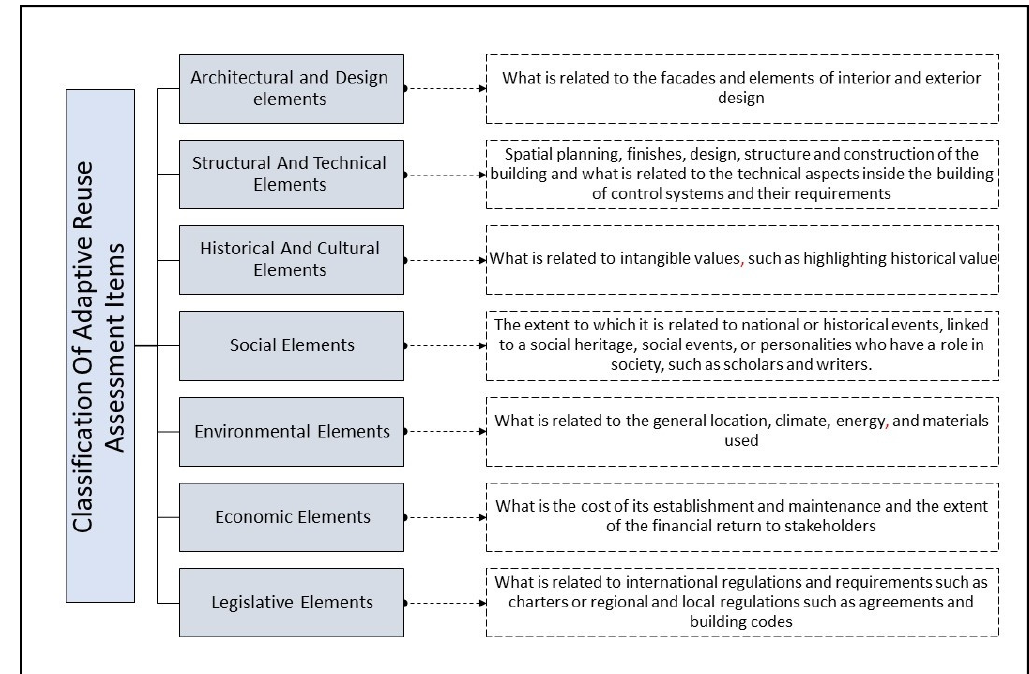
Figure 3. Classification of adaptive reuse assessment items.